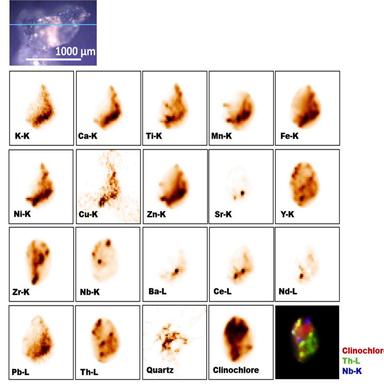
A Fen-Gruveåsen particle is shown on the top-left, mounted on a capillary as measured with both μ-XRF/XRD tomography and μ-CT. The μ-XRF-XRD tomography results are shown as elemental and mineral distribution maps, collected in a virtual cross section at the position indicated by the horizontal line in the topleft photograph. Map size 2000 � 2000 μm2 , stepsize 20 μm.